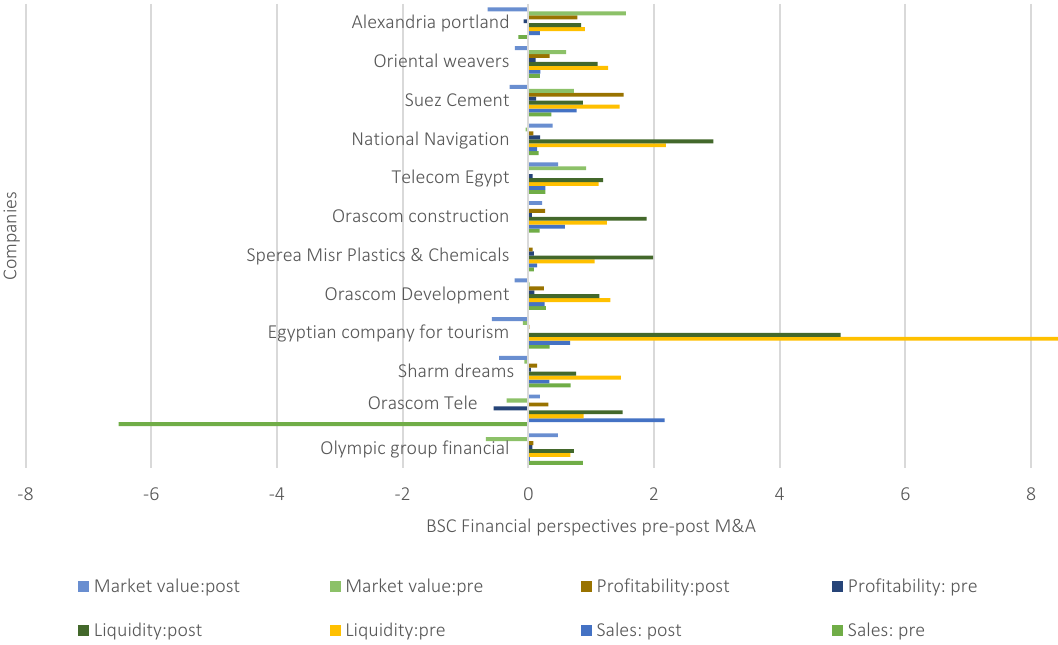
Figure 1. Pre- and post-M&A financial perspective across the